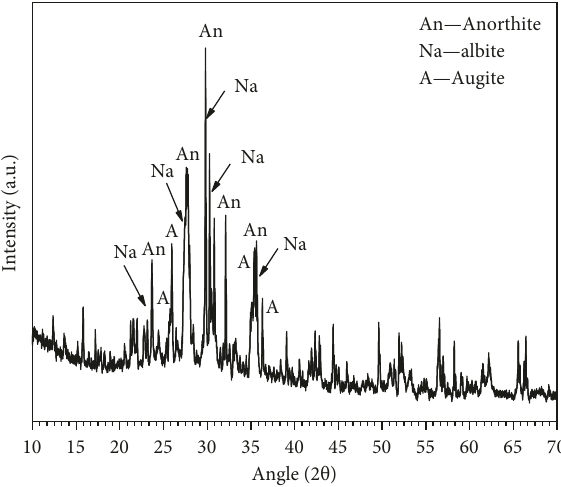
Figure 3: The XRD pattern of lunar soil simulant.